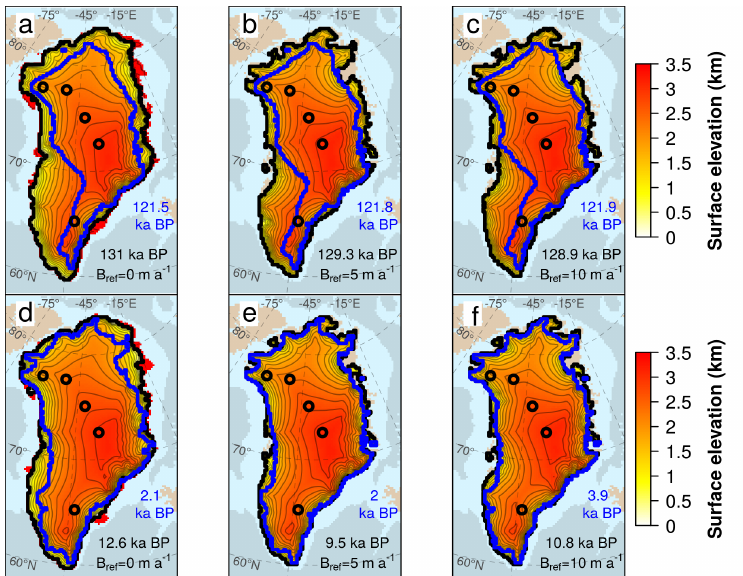
Figure 3. Glacial maximum GrIS surface elevation (km) simulated at Termination II (a–c) and Termination I (d–f) for different values of the reference basal melting rate ( B ref = 0, 5, 10ma − 1 ) under constant oceanic conditions ( κ = 0). The timing at which the ice volume reaches its maximum value during a glacial cycle depends on the experiment and is stated in black for each snapshot. Blue lines indicate the GrIS extension at the following peak of deglaciation with its corresponding timing reported in blue. Red zones represent the ice shelves extending beyond the glacial maximum grounding line (black line). Black circles indicate the locations of the Camp Century, NEEM, NGRIP, GRIP and Dye3 ice cores (from north to